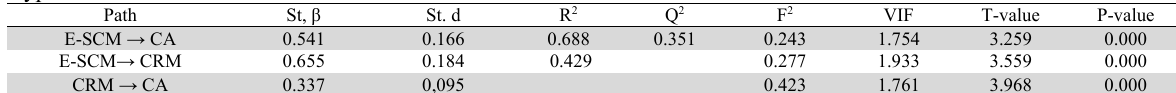
Hypothesized Direct Effects Structural Model